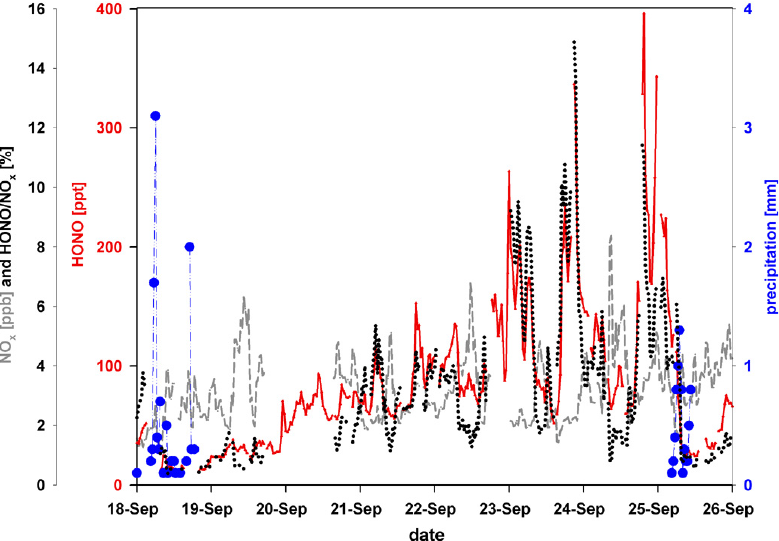
Fig. 2. Time series of HONO at 0.5m above the forest floor (red line), NO x (grey dashed line) and HONO/NO x ratio (black dotted line) from 18 (00:00CET) to 26 (00:00CET) September 2007 at the “Waldstein-Weidenbrunnen” research site. This dry period was delimited by rain events marked with blue dots (half hourly values).